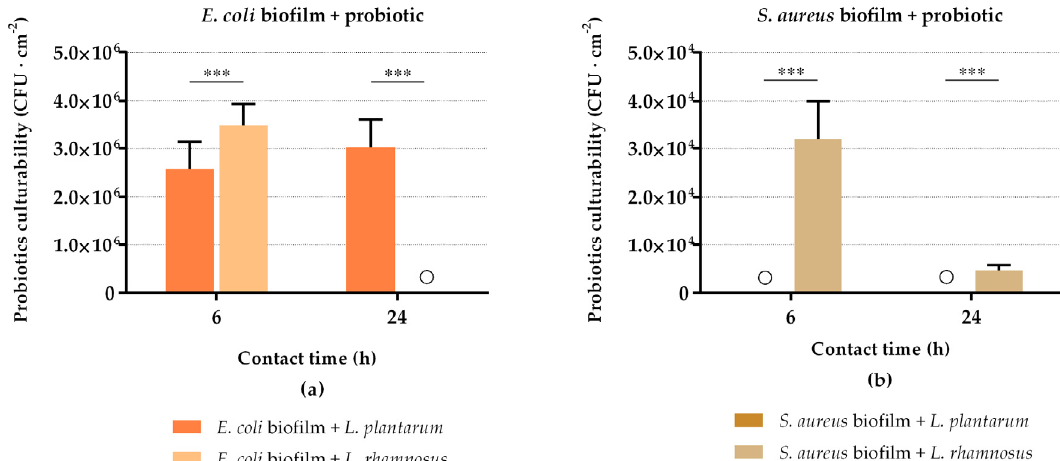
Figure 2. Culturability of attached L. plantarum and L. rhamnosus cells after 6 h and 24 h of contact with E. coli ( a ) and S. aureus ( b ) biofilms. The data present the mean and SD of at least three independent experiments. Statistically significant differences between probiotic strains for each time point were considered for p -values < 0.05 (*** indicates p < 0.001). “ ” indicates that no colonies were detected. (cid:35)